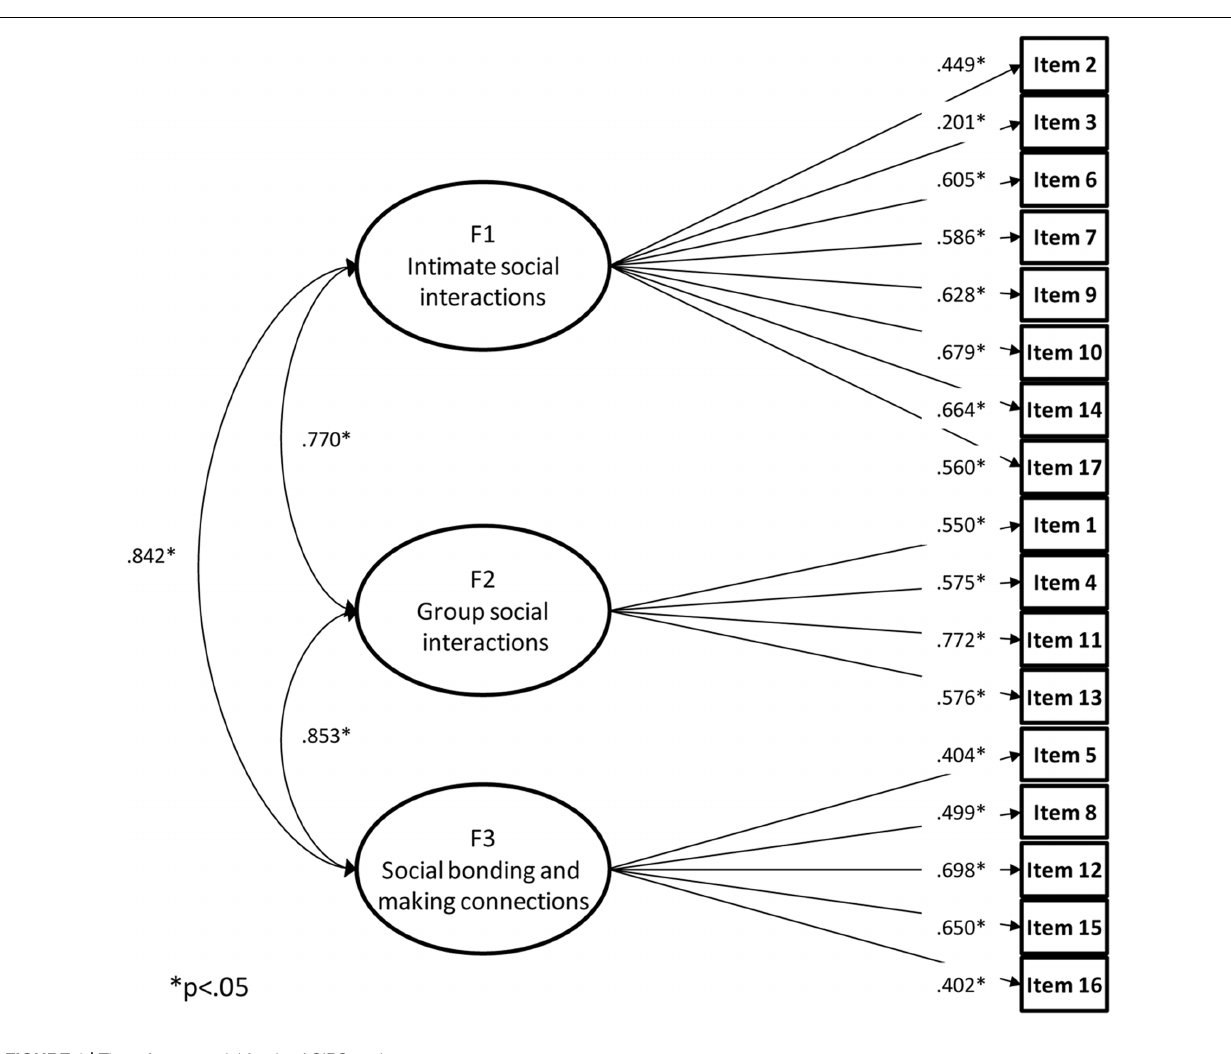
FIGURE 1 | Three factor model for the ACIPS